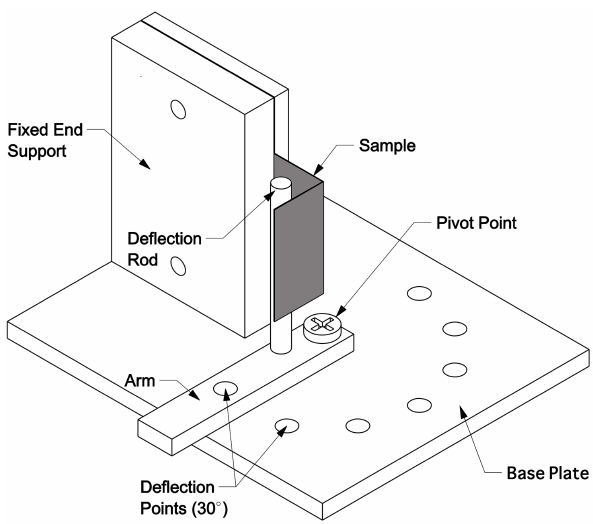
Figure 3. Isometric view of the test fixture. The clamped sample is shaded.